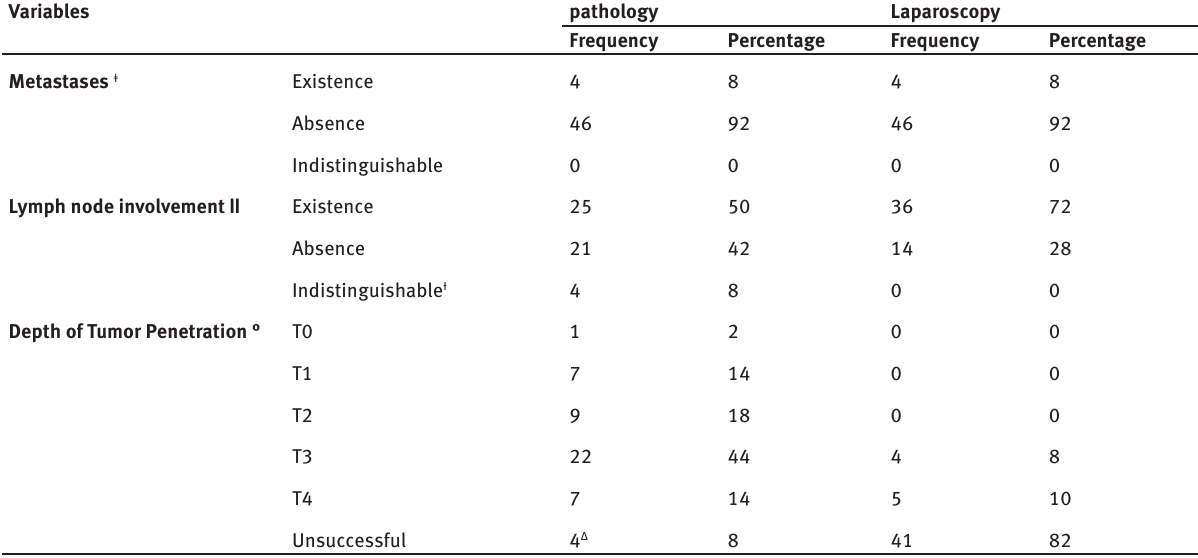
Table 1: Descriptive results of the state of metastasis (M), lymph node involvement (N) and tumor penetration depth (T) of the patients participating in the research based on two methods of laparoscopy and pathologic evaluation.